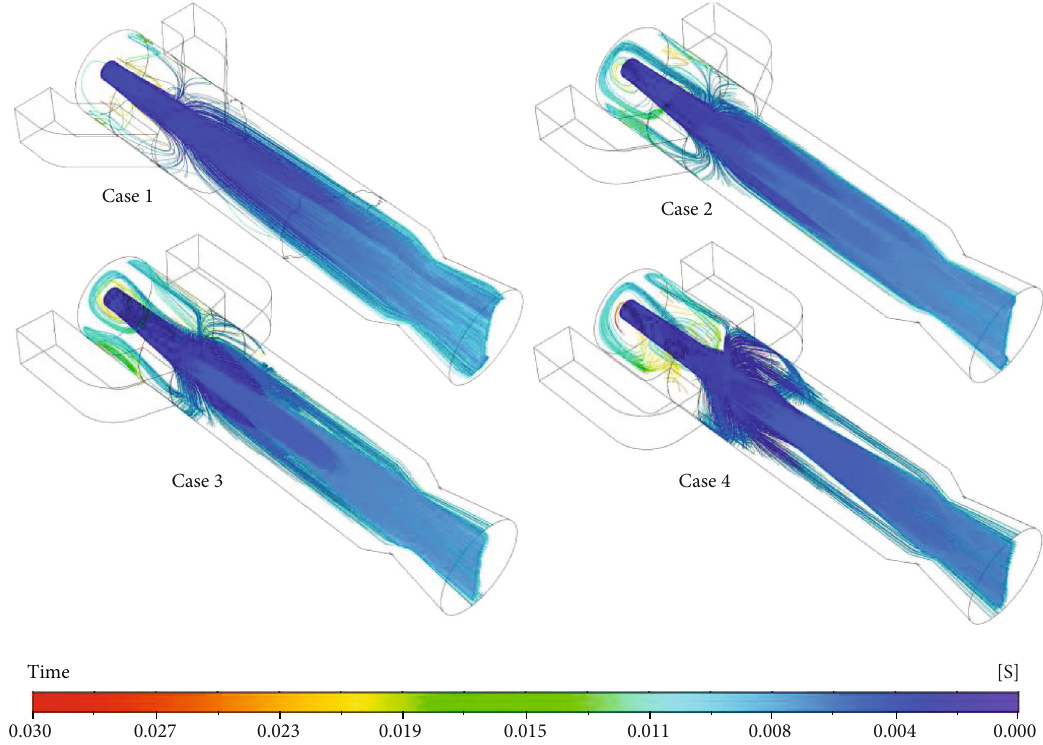
Figure 15: The trajectories of the boron particles were mainly concentrated on the regions of afterburner heads and the axial planes of symmetry. The vortexes in the heads of the afterburners and near the air inlet exits were enhanced.